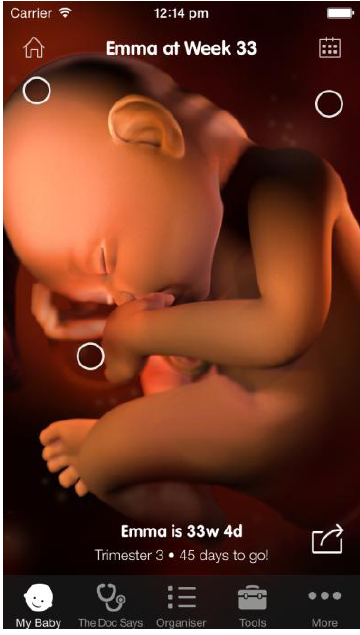
Figure 1. Screenshot from Sprout app which reveals a very humanised image of a foetus who appears to be sleeping and sucking its thumb. Despite not being born yet, the foetus has already been named Emma. Source: Med ART Studios (with permission to use